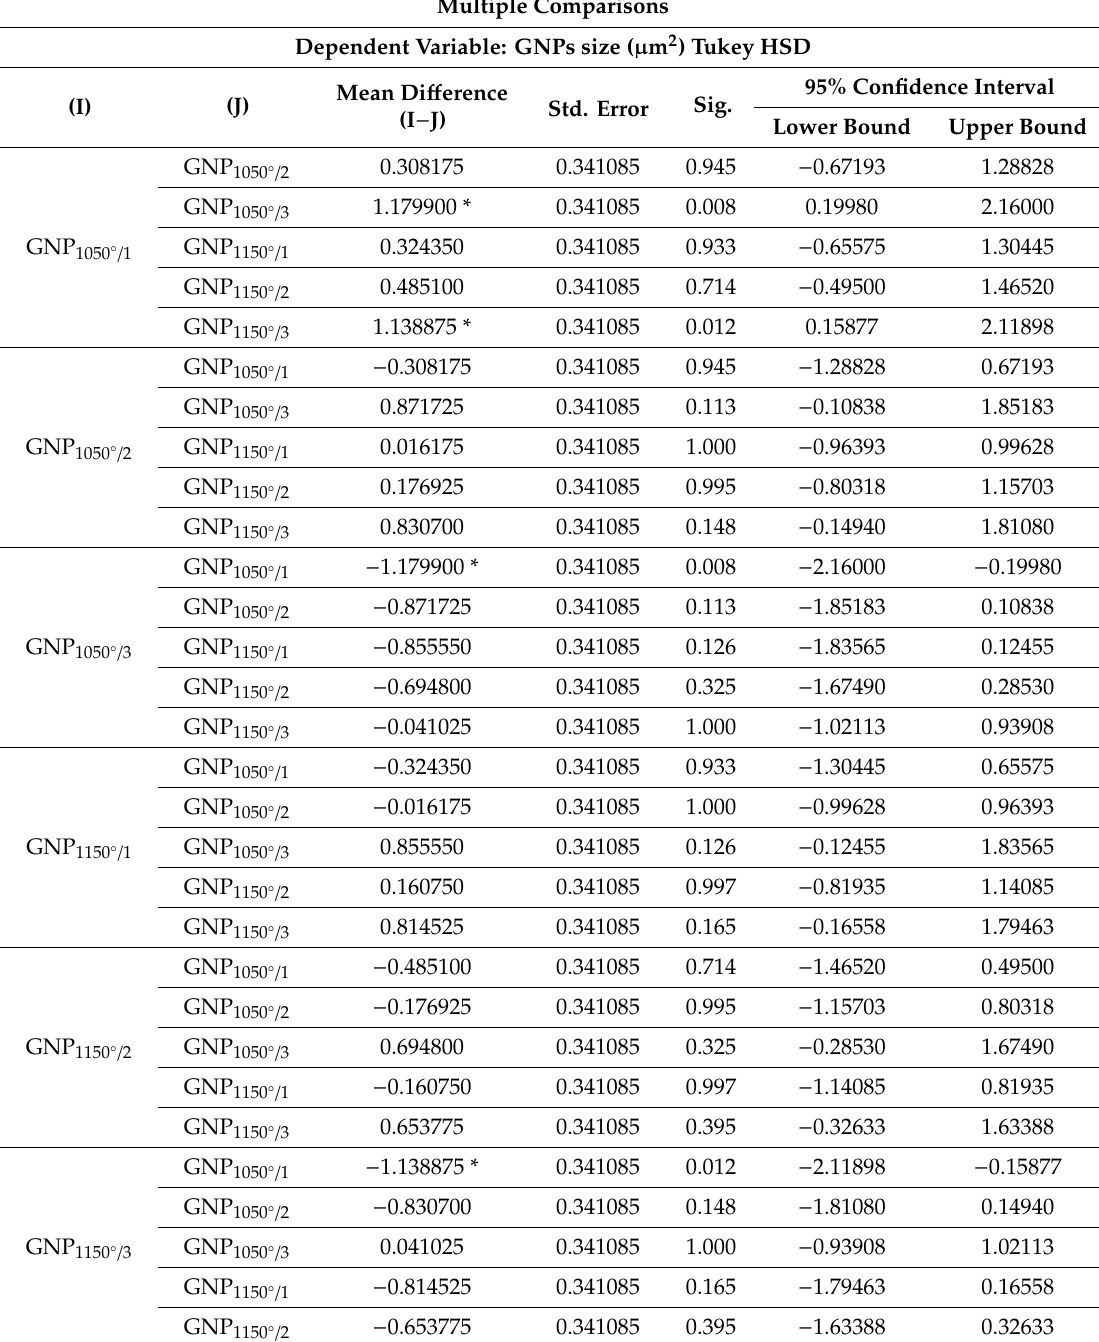
Table 2. Di ff erences in sizes of the six GNP groups. Multiple